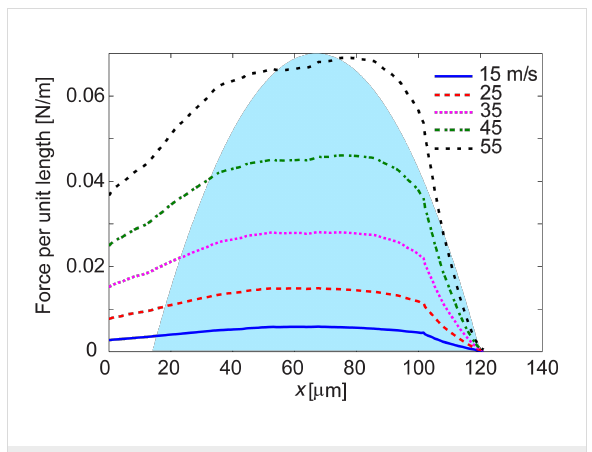
Figure 3: Force per unit length as a function of the fluid speed experi- enced by cantilever NCHV. The fixed end of the cantilever is at x = 0. The shaded area is a sketch of the fluid speed profile escaping the channel and also indicates the boundaries of the microchannel exit along the x